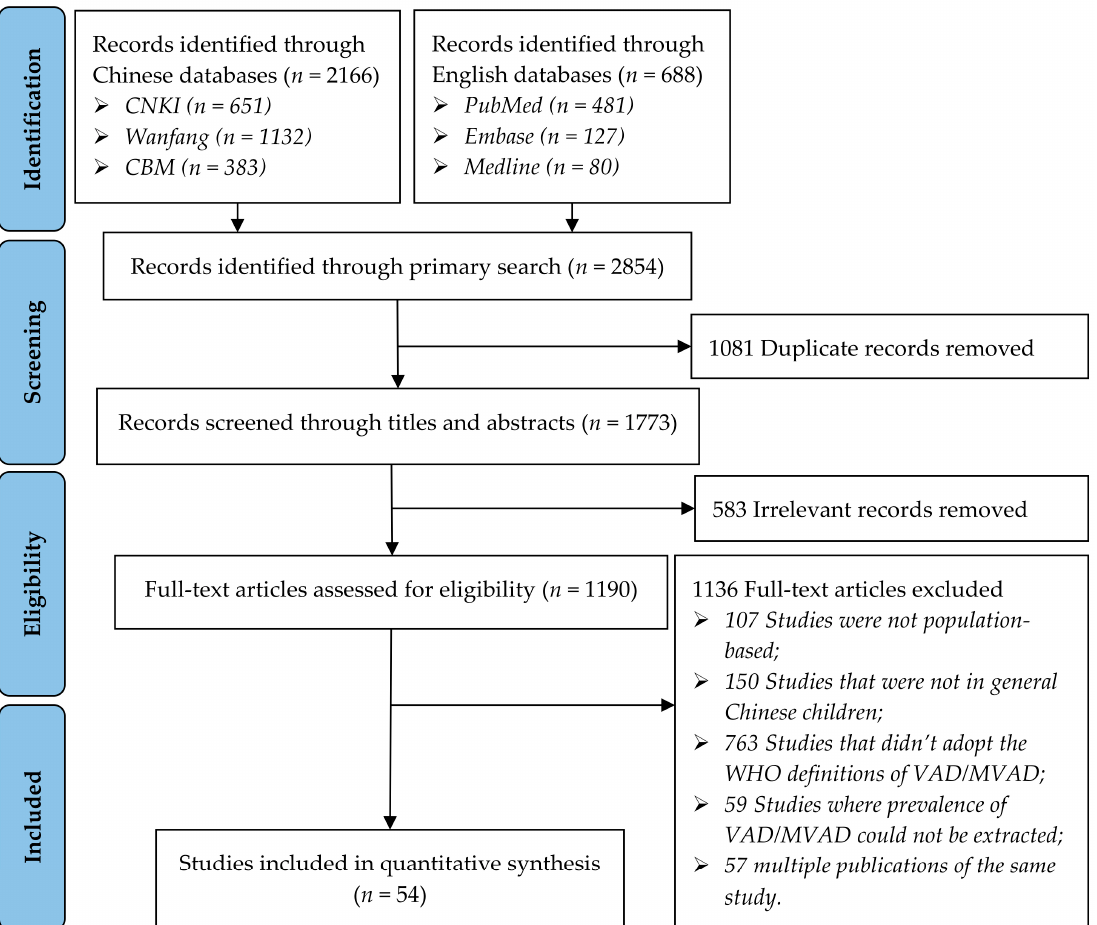
Figure 1. PRISMA flow diagram of study selection process. PRISMA, Preferred Reporting Items for Systematic Reviews and Meta-Analyses; CNKI, China National Knowledge Infrastructure; CBM, Chinese Biomedicine Literature Database; WHO, World Health Organization; VAD, vitamin A deficiency; MVAD, marginal vitamin A deficiency.